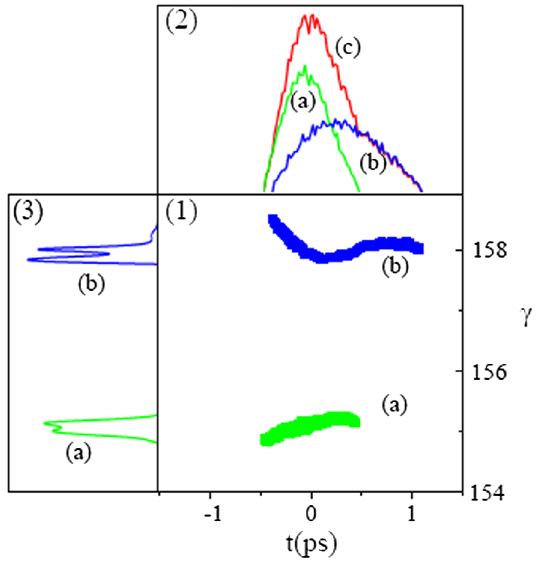
beam (B), instead, even if it is better as regards the global parameters, the two beamlets have different radii and different emittance, the lower energy one being worse than the other one. These beams are the simulations of two different working points used in the two-color FEL experi- ment and discussed in [16].